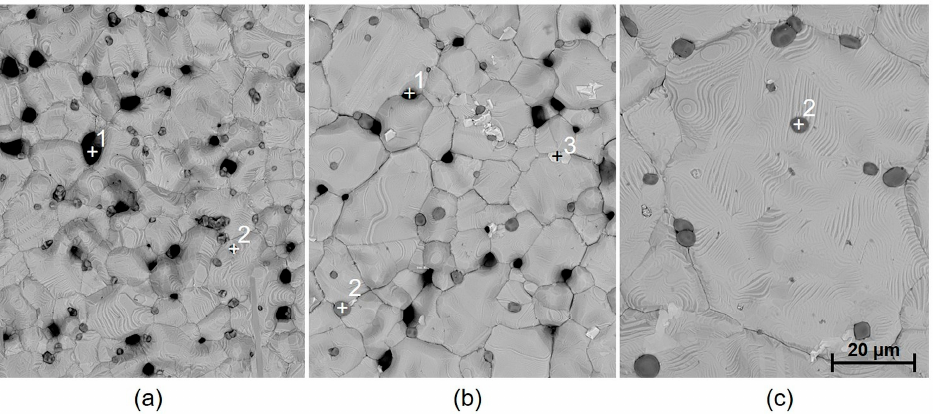
Figure 7. SEM image of the surface of fired paste C8717E: ( a ) 1 layer and 1 firing (specimen group 1), ( b ) 2 layers and 2 firings (specimen group 5), and ( c ) 2 layers and 2 firings, flowed by a two-hour annealing (850 ◦ C). Spot 1, pores; spot 2, Cu 2 O; spot 3, Bi 2 O 3 , SiO2, and Al 2 O 3 .